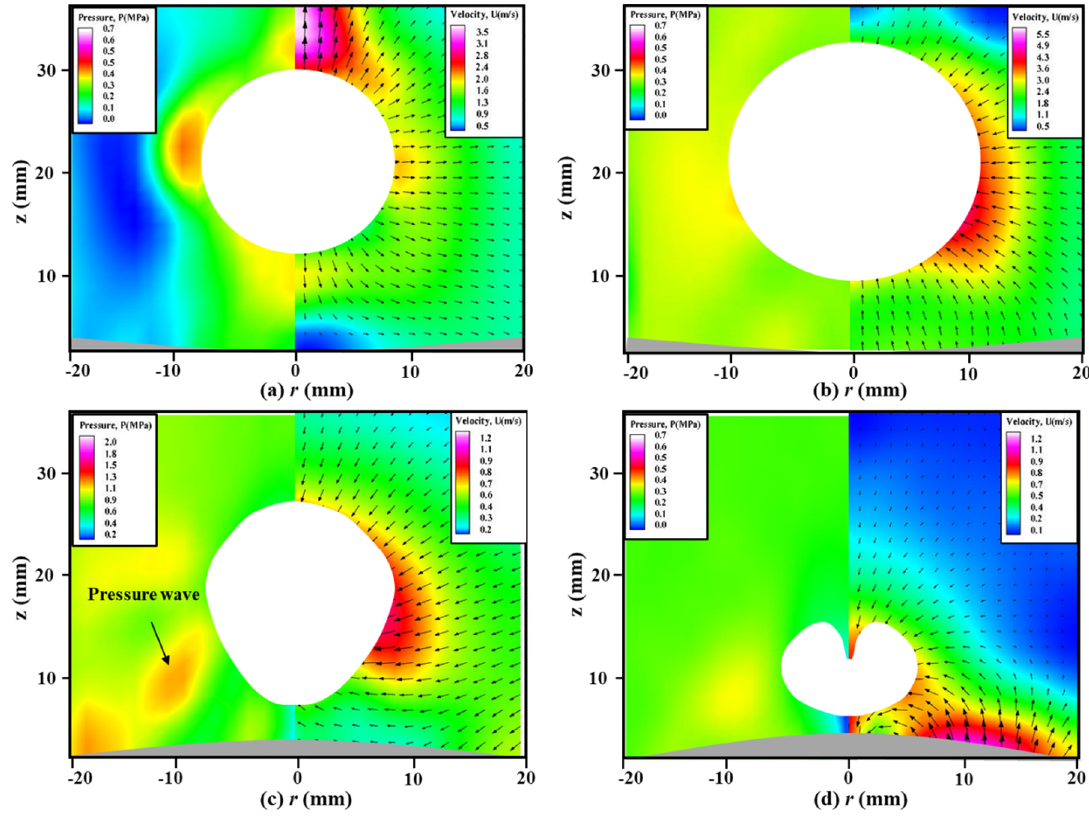
Figure 9. The measured velocity fields (right) and calculated pressure contours (left) around a bubble near the elastic boundary for γ = 1.20 and R m = 20.0 mm at typical time of ( a ) t = 0.92 ms, ( b ) t = 3.08 ms, ( c ) t = 3.36 ms and ( d ) t = 4.16 ms.